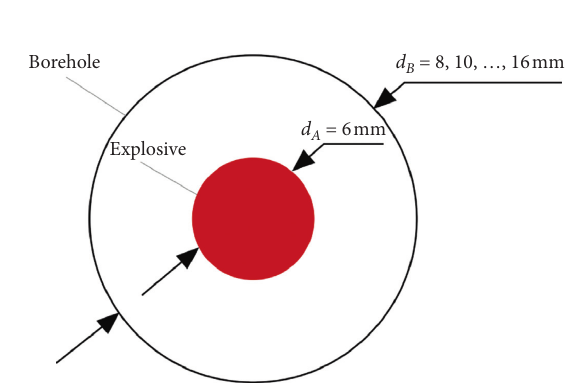
Figure 6: Diagram of the charge